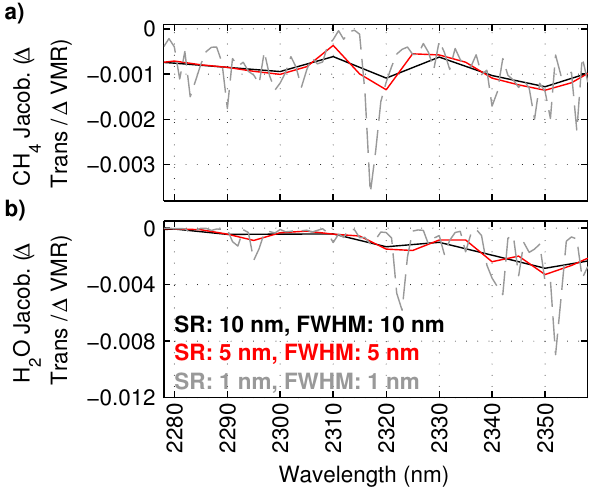
Fig. 16. (a) For the lowest layer of the atmopsheric model (height up to 1.04km), the CH 4 Jacobian calculated for AVIRISng (red) indicates improved sensitivity compared to the CH 4 Jacobian for AVIRIS (black). Even greater sensitivity can be achieved using a finer spectral resolution (SR) and FWHM (dashed grey). (b) H 2 O Jacobians calculated for the same three